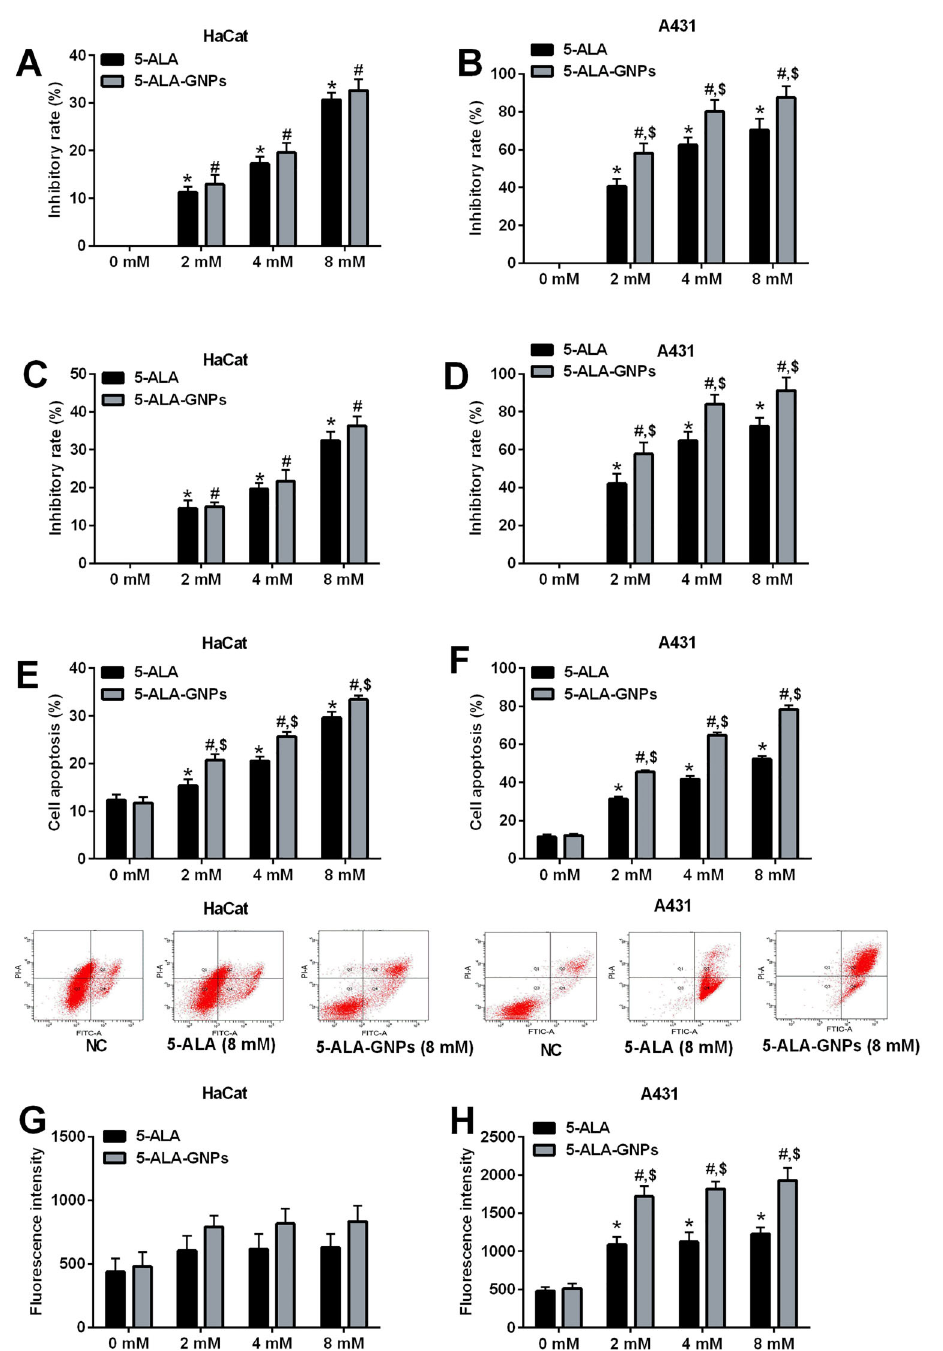
Figure 4. Effects of in vitro photodynamic therapy (PDT) on cell viability, cell apoptosis, and singlet oxygen generation in HaCat and A431 cells. Cell viability of ( A ) HaCat and ( B ) A431 cells after in vitro PDT with 5-aminolevulinic acid (5-ALA (2, 4, and 8 mM), 5-ALA- gold nanoparticles (GNPs (2, 4, and 8 mM)) or phosphate-buffered saline (PBS (NC)) were determined by MTTassay. Cell viability of ( C ) HaCat and ( D ) A431 cells after similar treatment were determined by Alamar blue assay. Cell apoptosis of ( E ) HaCat and ( F ) A431 cells after similar treatment were determined by fl ow cytometry. Singlet oxygen generation of ( G ) HaCat and ( H ) A431 cells after similar treatment were determined by SOSGR assay. Data are reported as means ± SD. *P o 0.05 compared to the 5-ALA (0 mM) group; # P o 0.05 compared to 5-ALA-GNPs (0 mM) group; $ P o 0.05, 5-ALA-GNPs group vs 5-ALA group (two-way ANOVA,